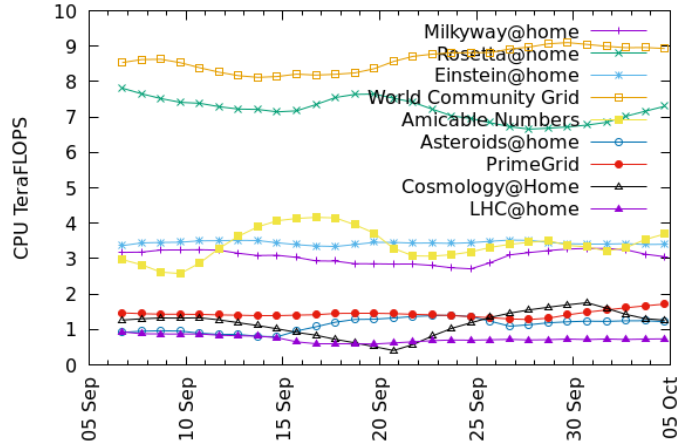
Figure 3. CPU throughput of the top 10 projects in 2020. The top two projects, which do COVID research, have larger allocation shares.